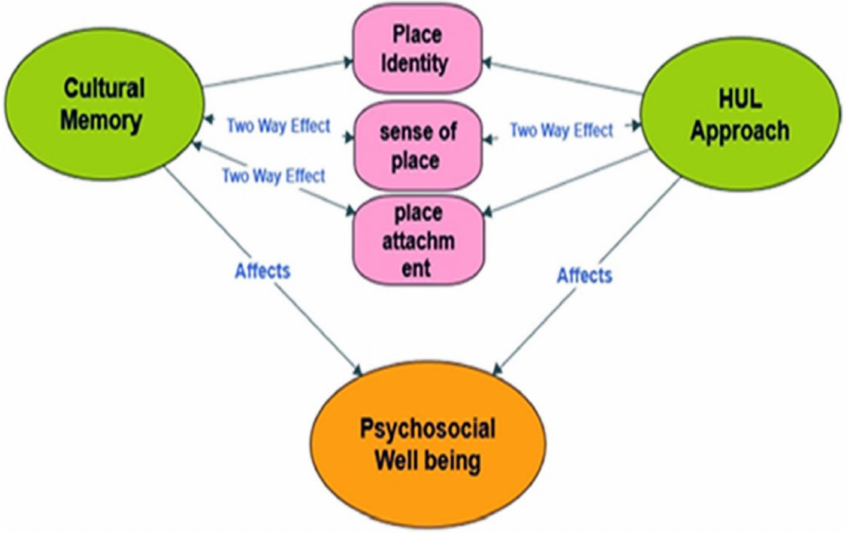
Figure 4. Research main concept themes diagram executed using Nvivo12 program. Source: F.